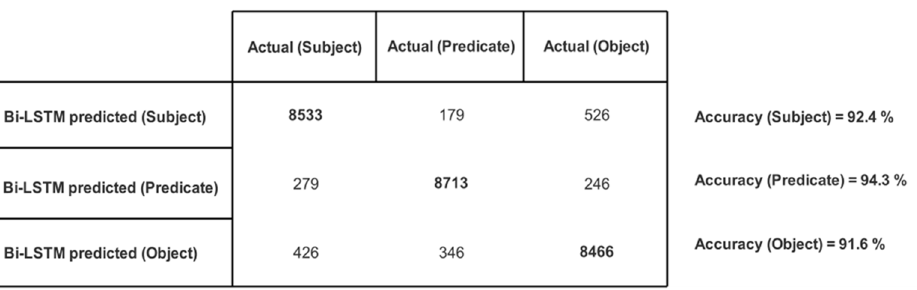
Figure 9. Confusion matrix showing no. of actual and Bi-LSTM predicted subjects/predicates/objects.